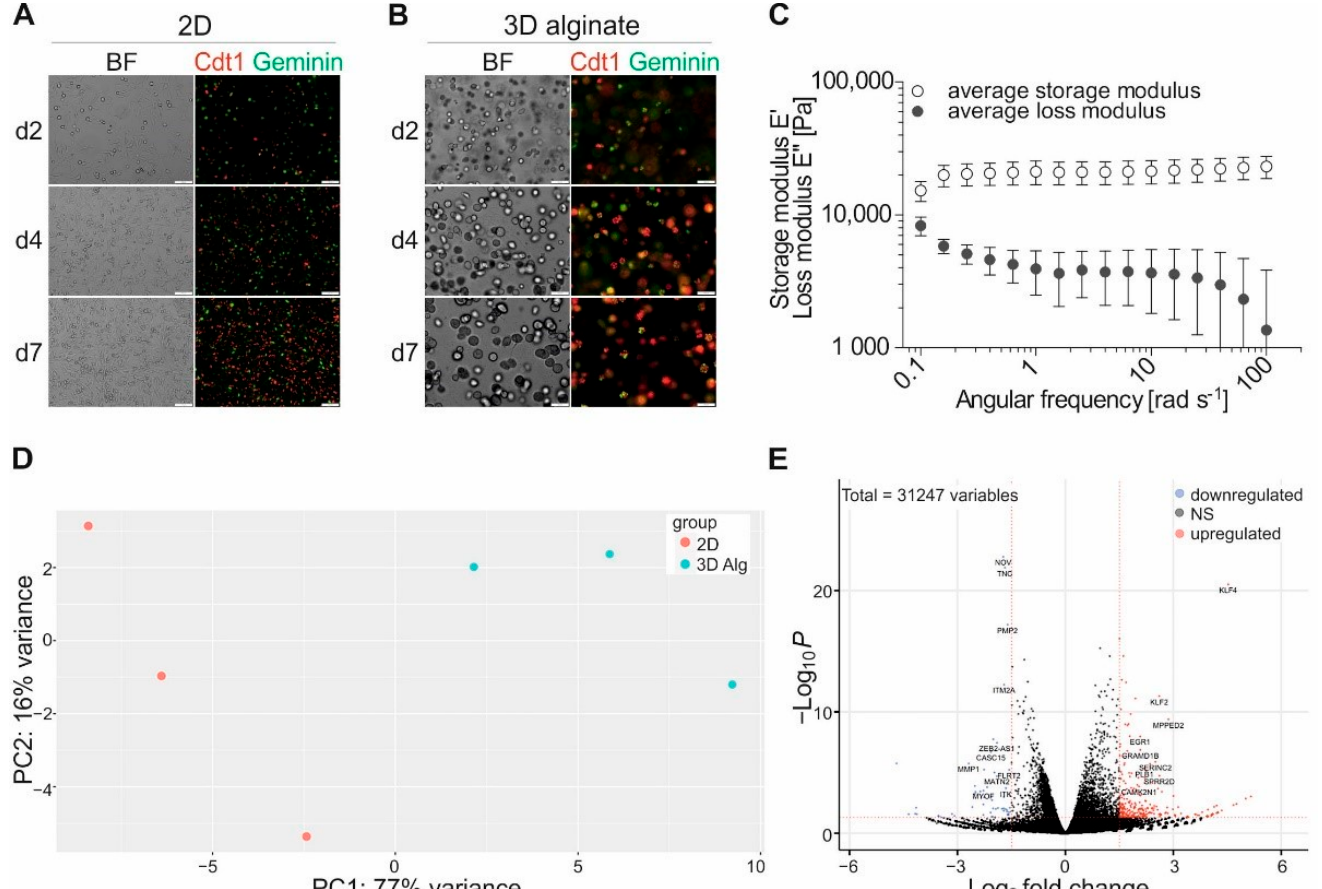
Figure 1. Differential phenotype and genotype of melanoma cell line Mel Im cultured in 2D versus 3D alginate. Fluorescence and bright-field images of Mel Im FUCCI after 2, 4, or 7 days of cultivation in ( A ) 2D or ( B ) 3D alginate, (Cdt1: Chromatin licensing and DNA replication factor 1), scale bars represent 100 µm; ( C ) Average storage and loss moduli ± SD determined for 0.6% alginate; ( D ) Principal Component Analysis (PCA) of RNA Seq samples; ( E ) Volcano plot of analyzed genes.